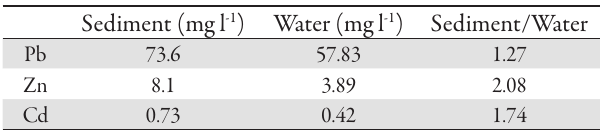
Tab. 2. Elemental concentration ratios between sediments and